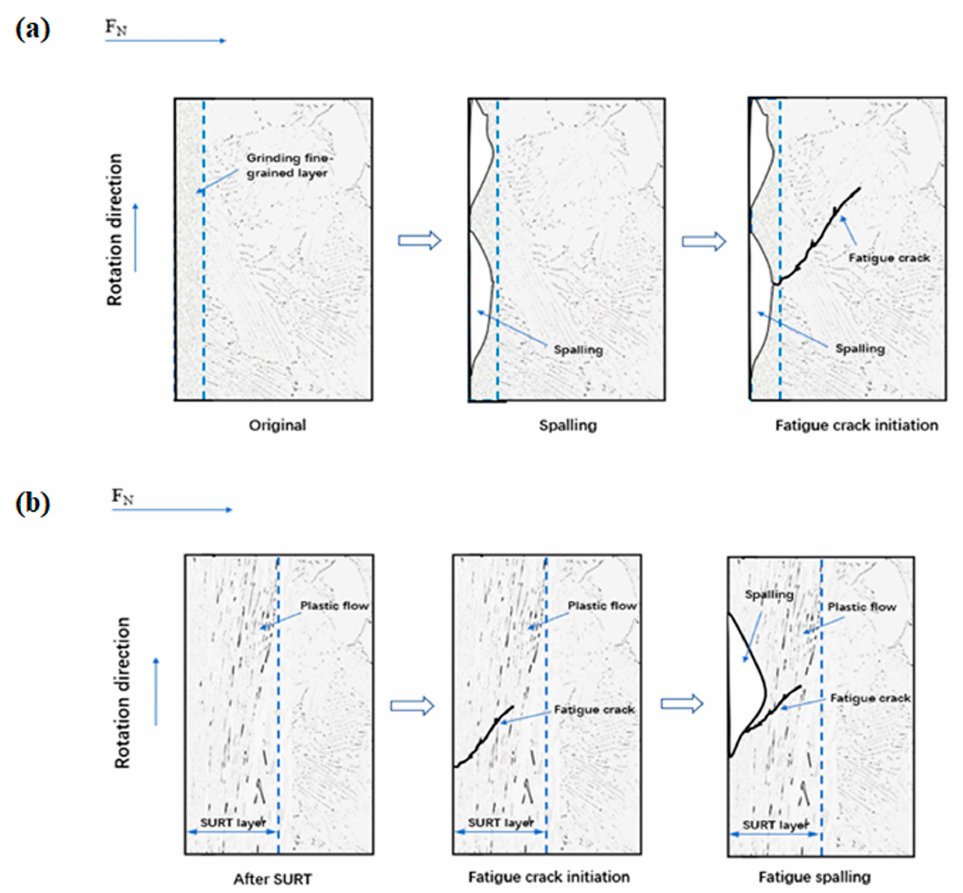
Figure 16. The schematic diagram of the formation process of RCF cracks: ( a ) the grinding processing sample and ( b ) the sample after